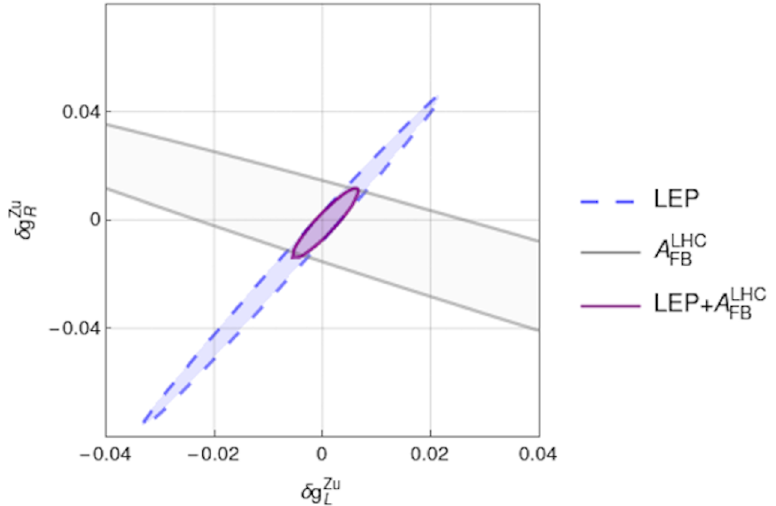
Figure 1 . Allowed regions (at 95% CL) for the corrections of the Z couplings to left- and right- handed up quarks. All other couplings are assumed to be given by their SM values. The marginal- ized bounds at 95% CL are δg Zu ∈ [ − 0 . 028 , 0 . 017] , δg Zu ∈ [ − 0 . 064 , 0 . 035] for the “LEP” fit and L R δg Zu ∈ [ − 0 . 004 , 0 . 005] , δg Zu ∈ [ − 0 . 012 , 0 . 009] for the “LEP+ A LHC ” L R FB